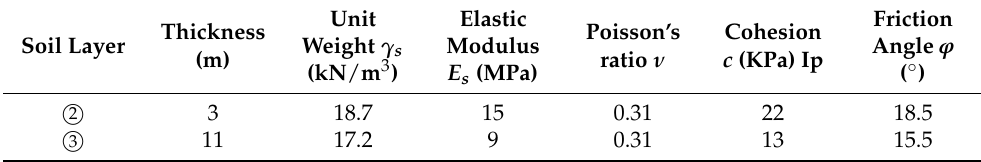
Table 3. Physical and mechanical parameters of